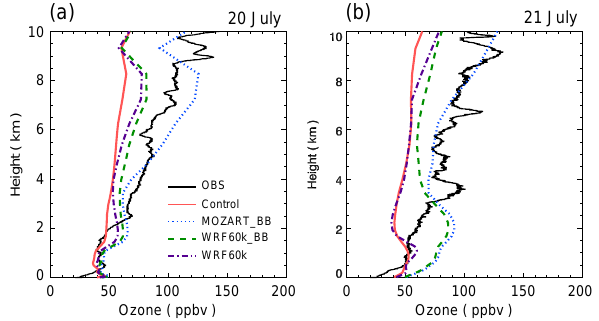
Fig. 17. Vertical distributions of observed and simulated O 3 mixing ratios on (a) 20 July (43.44 ◦ N, 69.28 ◦ W, 14:13 UTC) and (b) 21 July (42.52 ◦ N, 70.67 ◦ W, 13:48 UTC) for the time and location of profiles by ozone-sondes launched from the NOAA Research Vessel (Thompson et al., 2007).